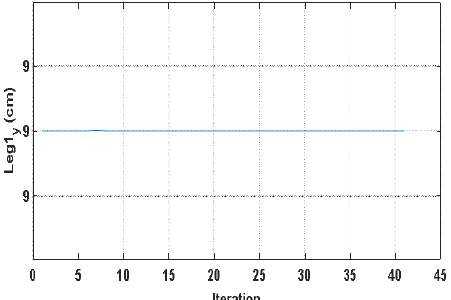
Fig. 20. Showing the changing of the leg tips along Y-axis during the quadruped walking.